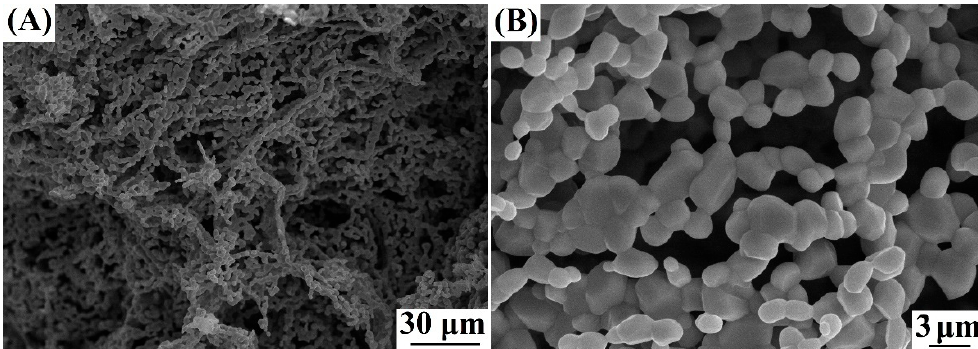
Figure 3. SEM images of sample 2 ( A , B ).